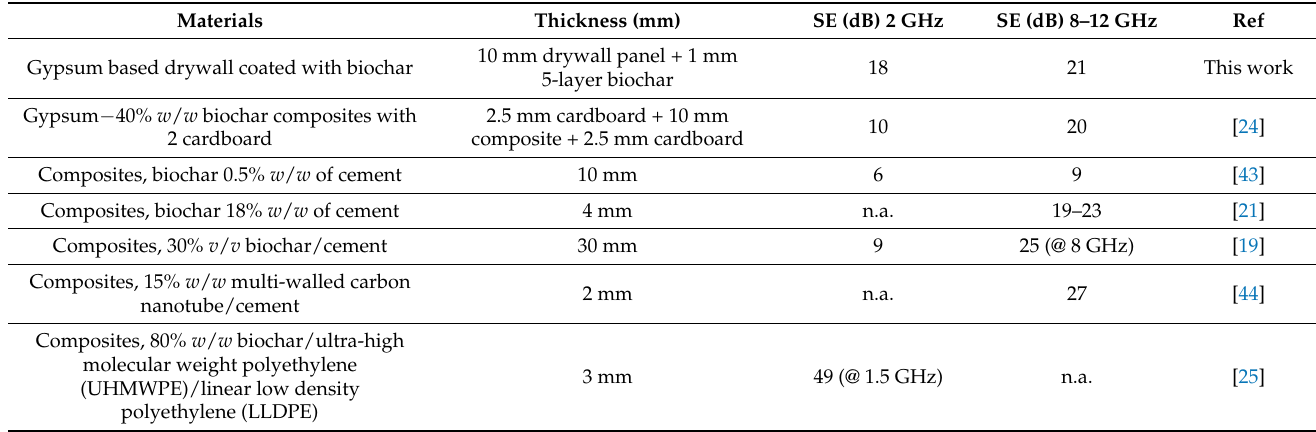
Table 1. Shielding effectiveness data for some biochar-based composites or drywalls for EMI shield- ing